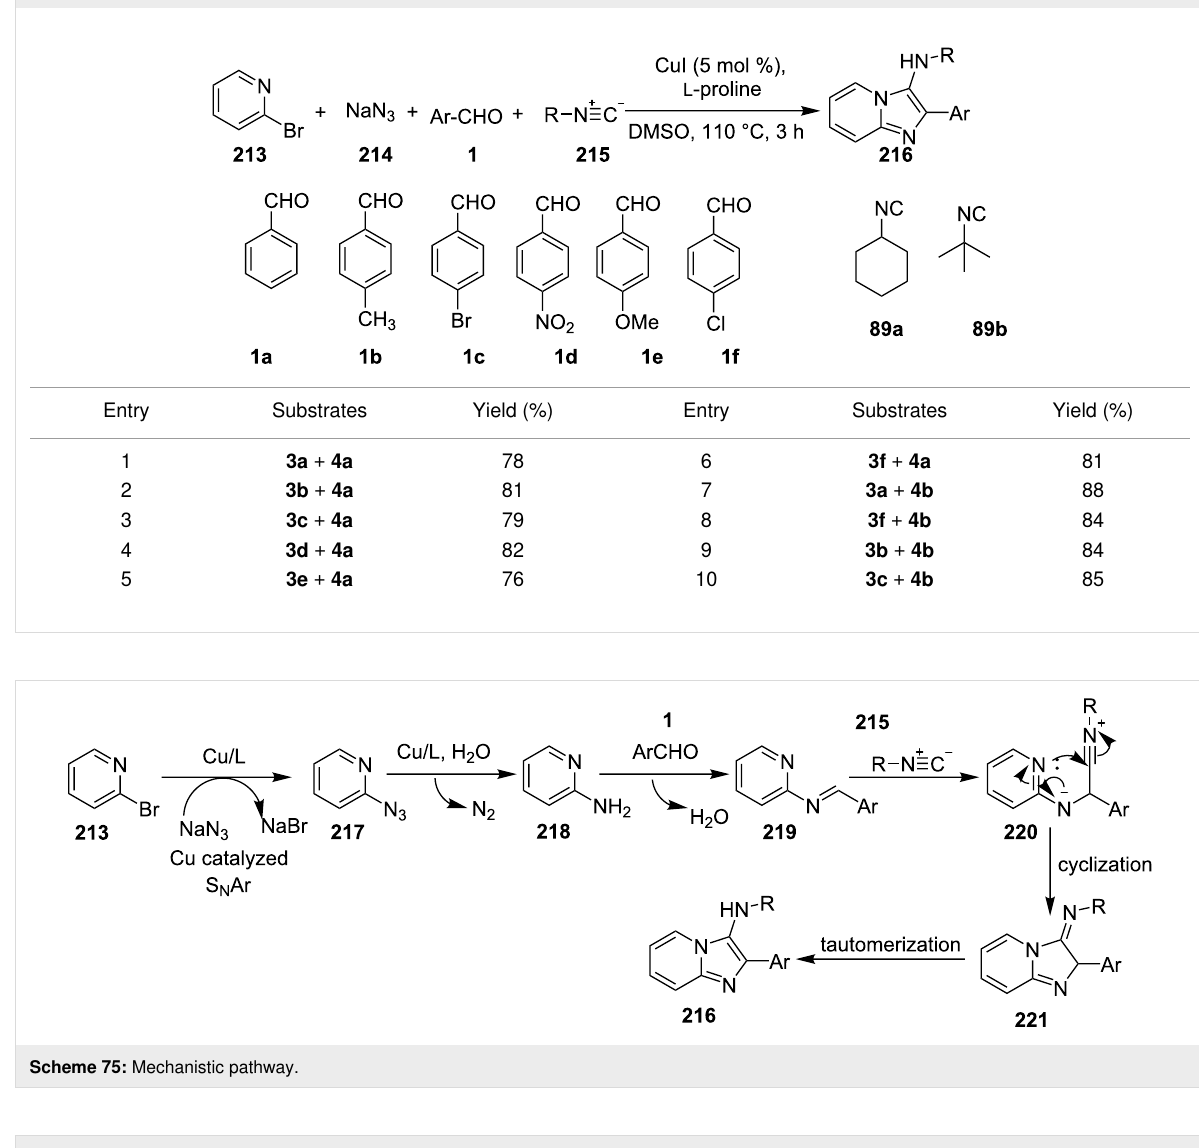
Table 5: Copper-catalyzed 4-CR for the synthesis of imidazo[1,2- a ]pyridine.